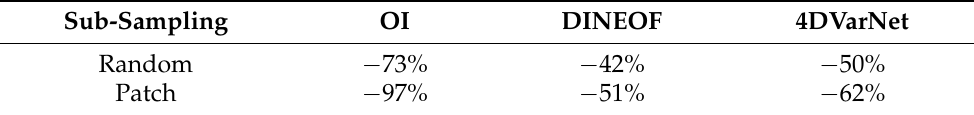
Table 3. Evolution of accuracy, from OSSE to OSE, in the form of a performance rate according to the formula 1 − RMSLE(OSE)/RMSLE(OSSE) expressed in percentage, using the RMSLE reported in Table 2.